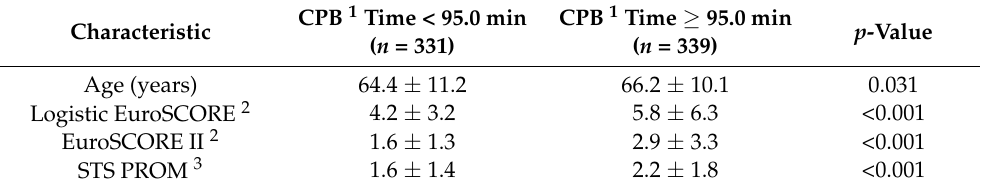
Table 7. Baseline characteristics of patients with CPB time of less than 95.0 min vs. 95.0 min or more.